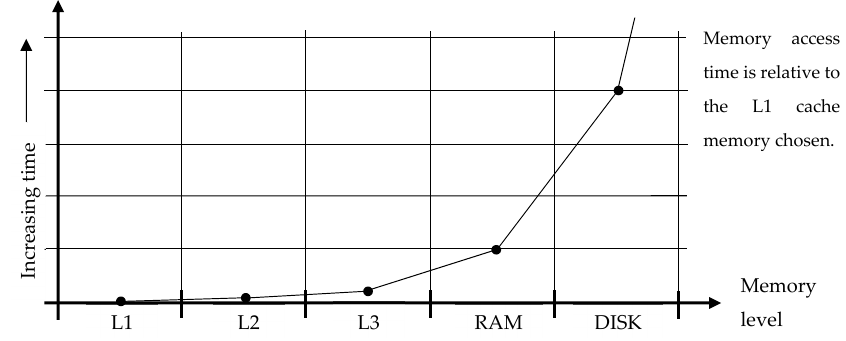
Figure 2. Algorithm execution (memory access) of time vs. memory hierarchy.